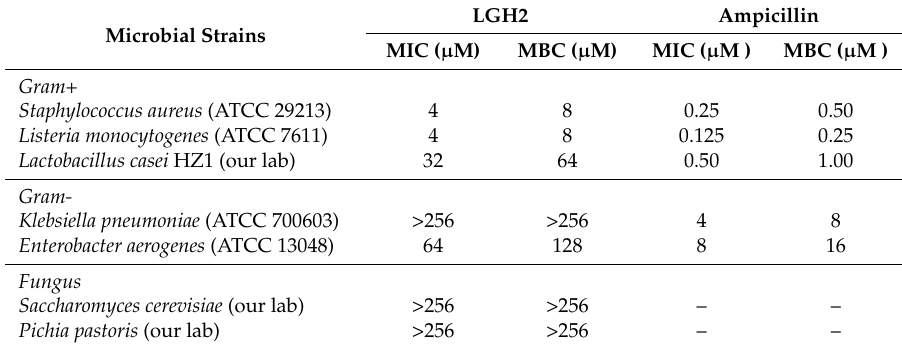
Table 2. Minimum inhibitory concentrations (MICs) and minimum bactericidal concentrations (MBCs) of LGH2.